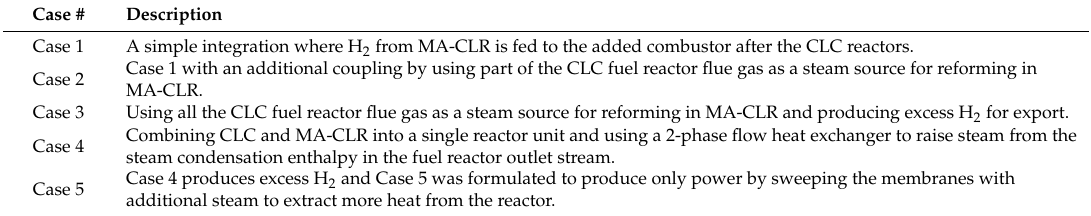
Table 2. Summary of the CLC and MA-CLC integrations investigated in this study.